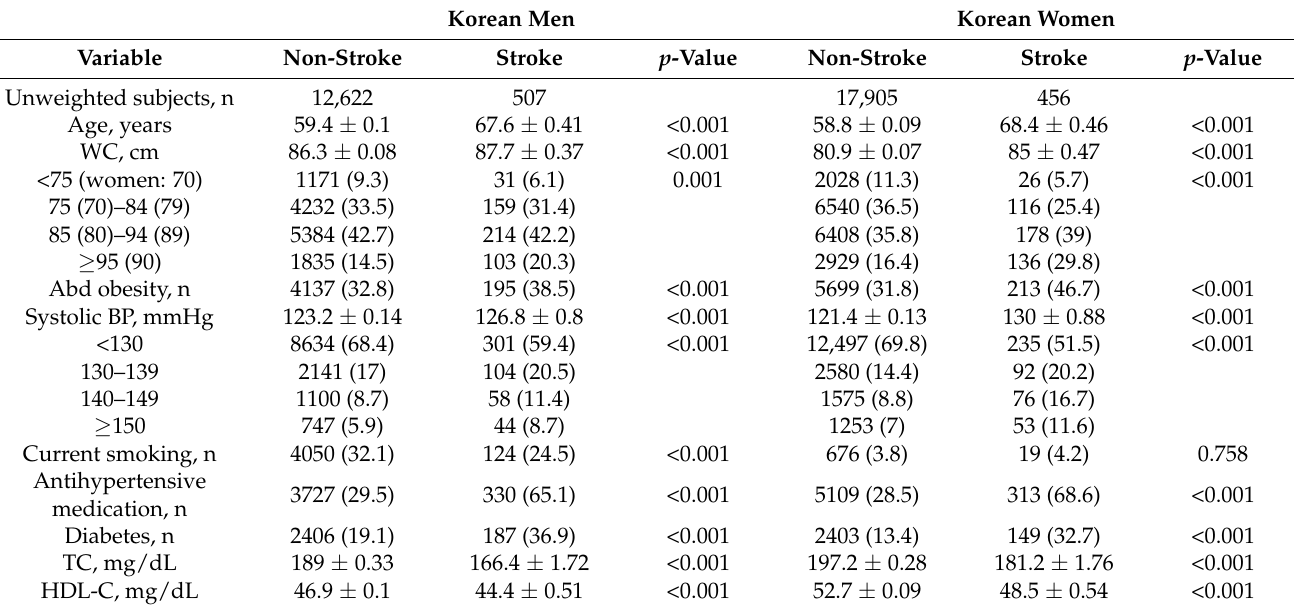
Table 1. Sex-specific general characteristics according to stroke status.